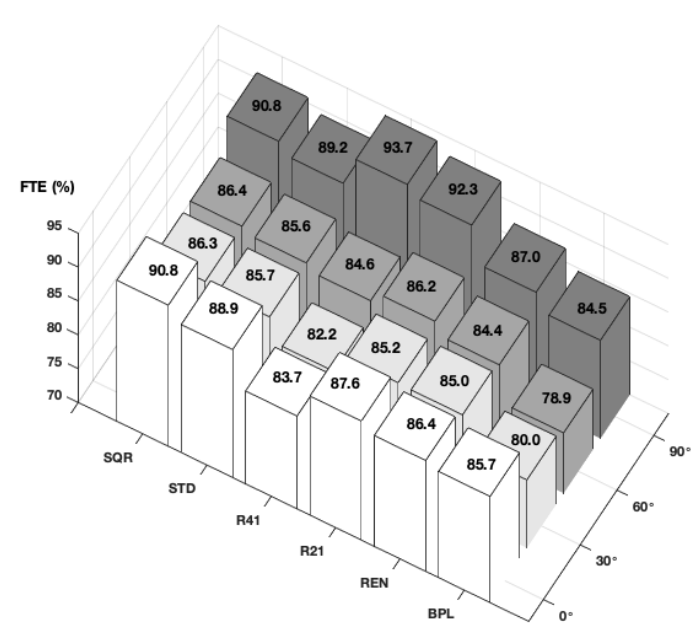
Figure 12. Average FTE for all template field shapes in each driving direction.